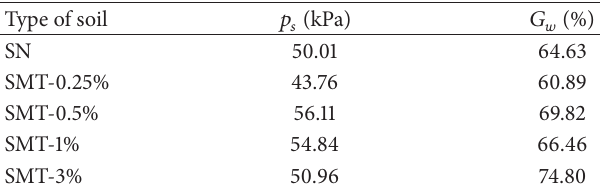
Table 6: 𝑝 𝑠 and 𝐺 𝑤 values presented by soil modified with total